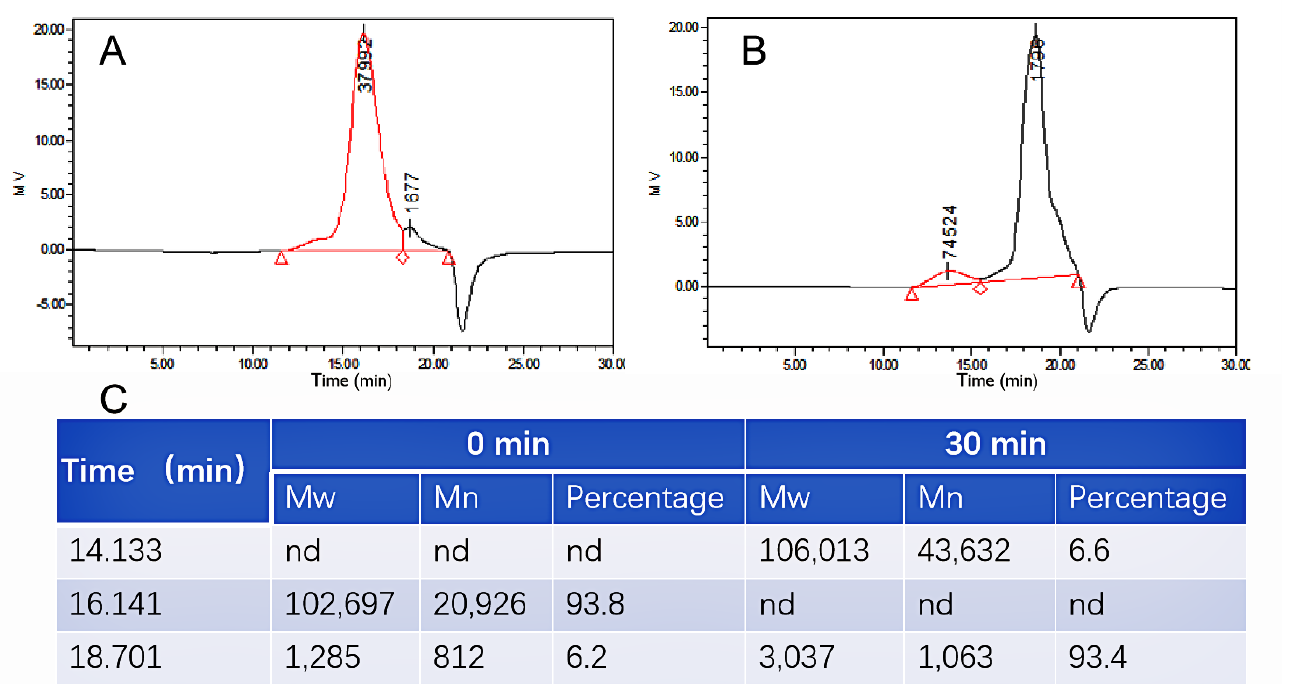
Figure 5. GPC analysis of the CS ( A ) and hydrolyzed CS ( B ) and the weight-average molecular weight ( Mw ) and the distributions ( C ). The 0 min and 30 min in C are the reaction time. Mn and nd mean the number-average molecular weight and not determined, respectively.